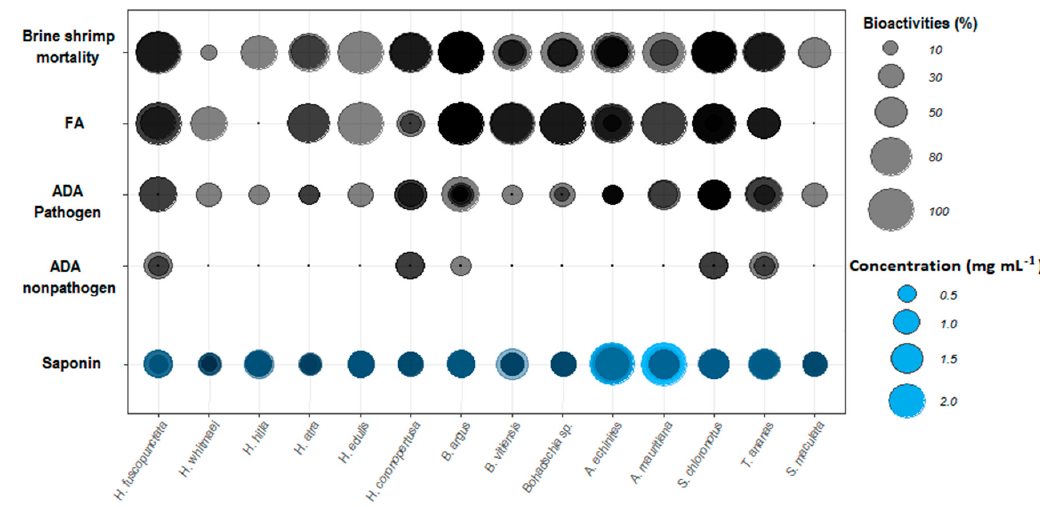
Figure 7. Overall biological activities of the tested sea cucumber crude extracts. Sizes of bubble plots represent the percentage of each bioactivity for the four different bioassays. Color intensities represent the overlap of the replicates (duplicates; cf. Figure 1). Abbreviations: FA = fish feeding assay (% deterrence), ADA = agar diffusion assay against environmental pathogenic and non-pathogenic bacteria.